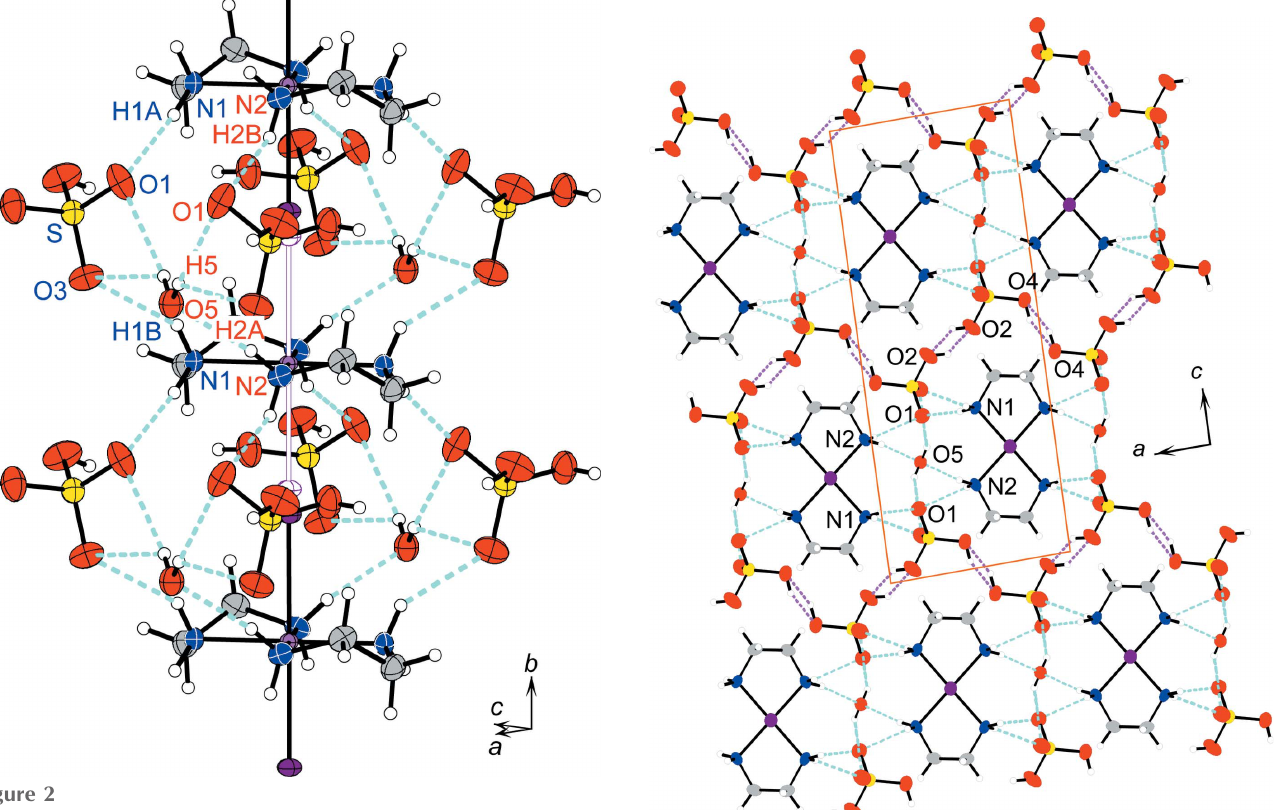
Figure 3 The crystal packing of compound (I), projected on the ac plane. Magenta dashed lines represent hydrogen bonds between the hydrogen sulfate ions. Light-blue dashed lines represent the other hydrogen bonds. Solid orange lines indicate the unit cell.